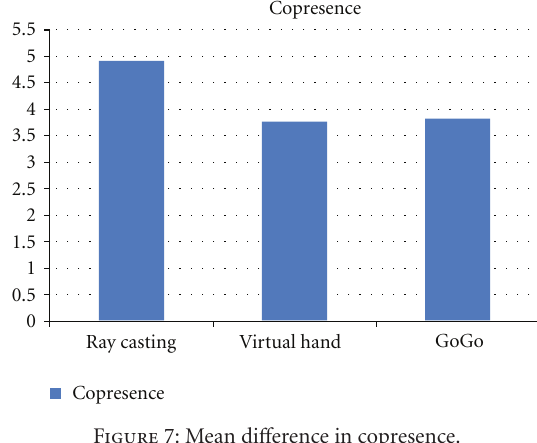
Figure 7: Mean di ff erence in copresence.